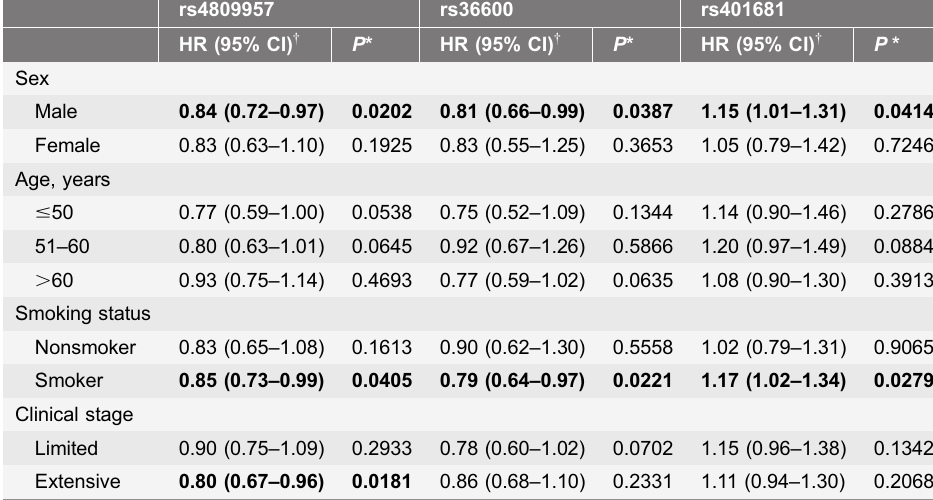
Table 4. Stratification analysis of association for the 3 significant